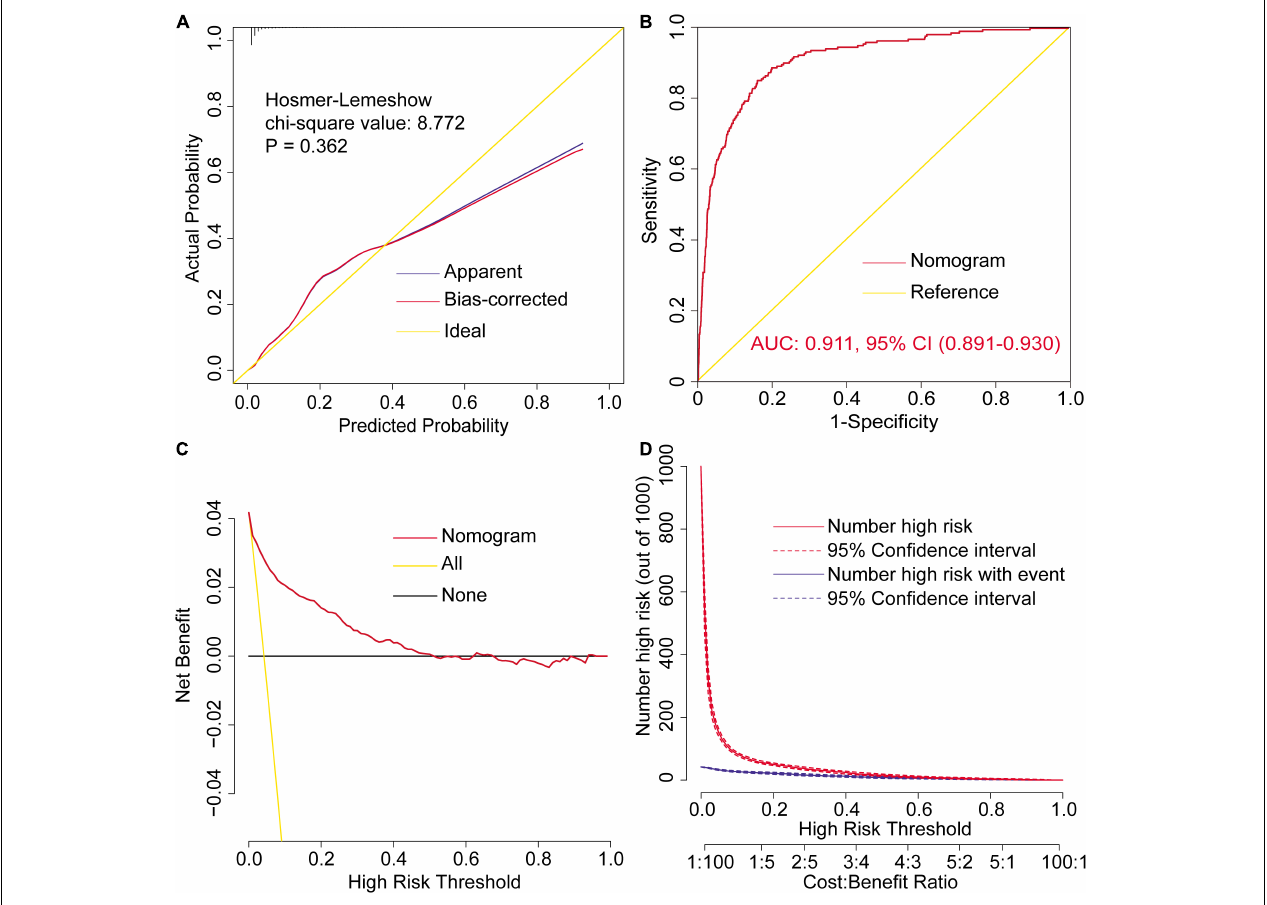
FIGURE 2 | Assessment of the final model for severe hypoxemia after cardiac surgery. Calibration plots and goodness-of-fit test (A) , ROC curves and the AUC (B) , decision curve (C) , and clinical impact curves (D) . AUC, area under the receiver operating characteristic curve; CI, confidence interval; ROC, receiver operating characteristic